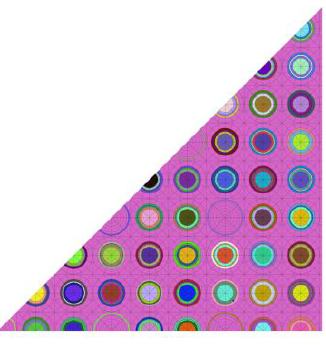
Figure 1. TDT/MOC spatial mesh for 1/8 th of a BEAVRS